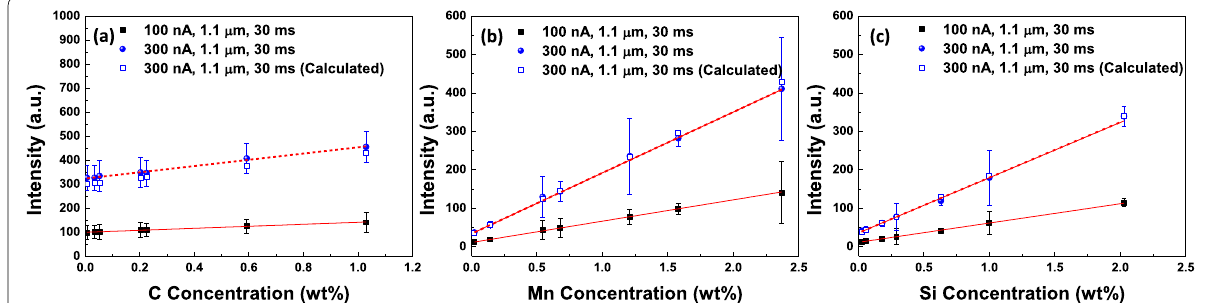
Fig. 4 Calibration curves under the different probe currents; a C Kα, b Mn Kα, and c Si Kα. The calculated data were obtained from the intensity in 1 10 − 7 A probe current by multiplying 3 ×